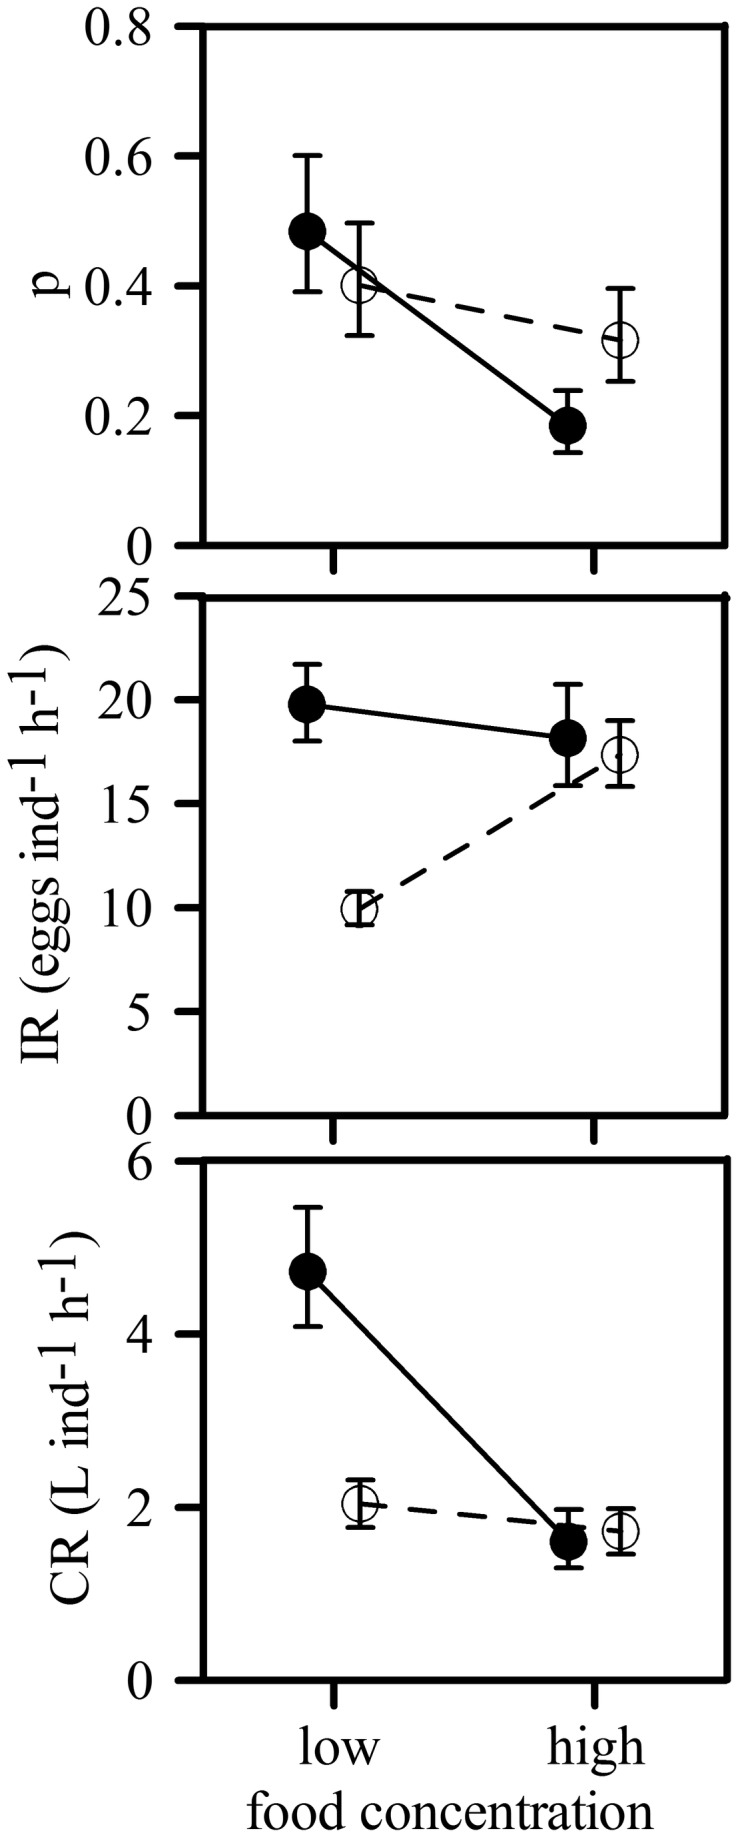
Effect of egg concentration and mixing regime on the proportion of feeding ephyrae (p), egg ingestion rate (IR) and egg clearance rate (CR) of

P

. noctiluca
 ephyrae feeding on Atlantic Bluefin tuna eggs.Dots represent geometric means adjusted to the mean ephyra size, which was 0.50 mm for p (includes all ephyrae used in each incubation) and 0.66 mm for IR and CR (includes only feeding ephyrae). Deviations correspond to ±10SE, where SE is the standard error of the log-transformed variables. Filled and empty dots correspond to the unstirred and stirred treatments, respectively.